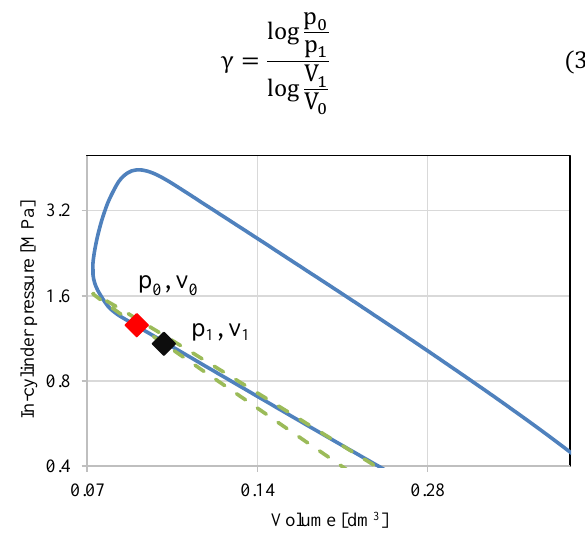
Fig. 2. Points used to calculate the polytrophic index To calculate the total heat release, equation (2) should be integrated. Additionally, the heat release charts were recalculated to the normalized range of 0–1. An exemplary course of cumulative heat release consistent with equation (4) is shown in Fig.